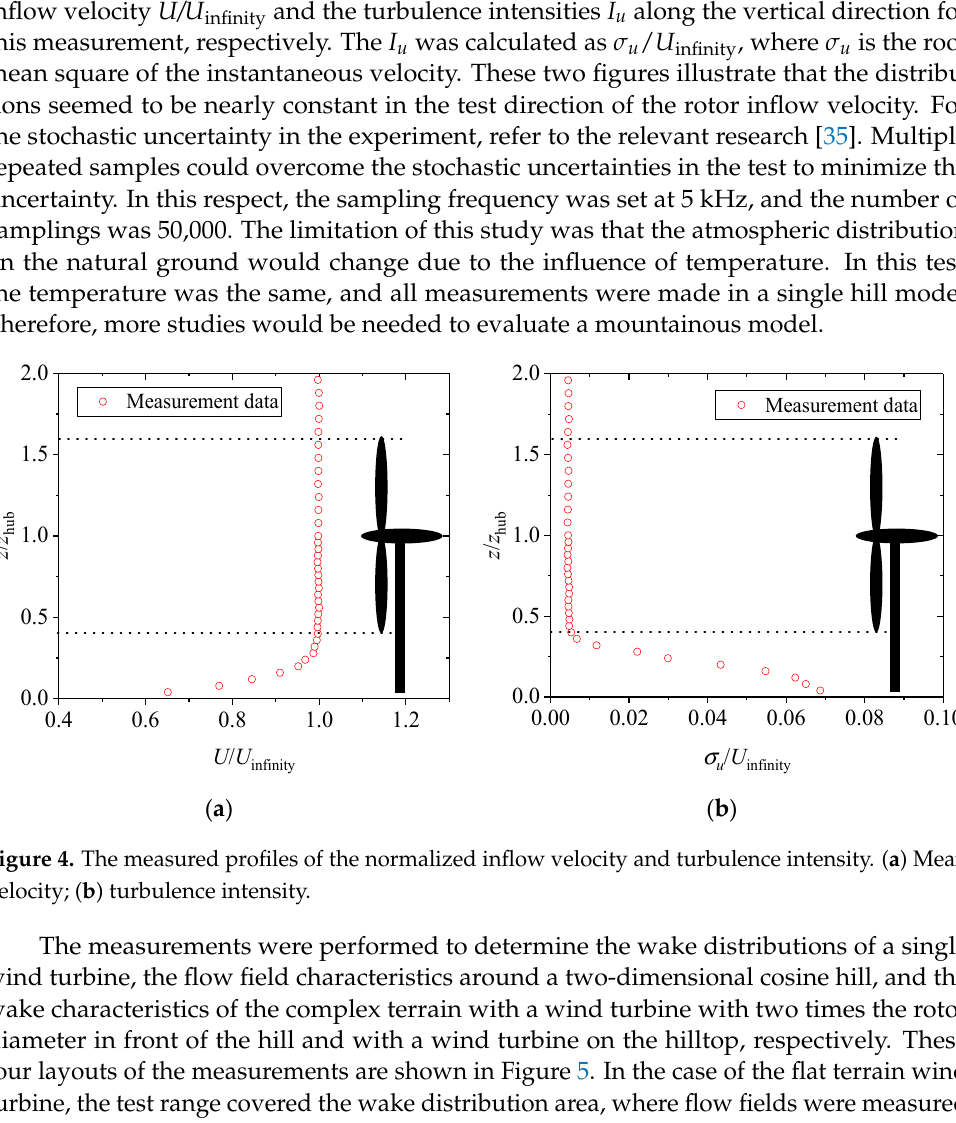
Figure 3. Photograph of the test setup.